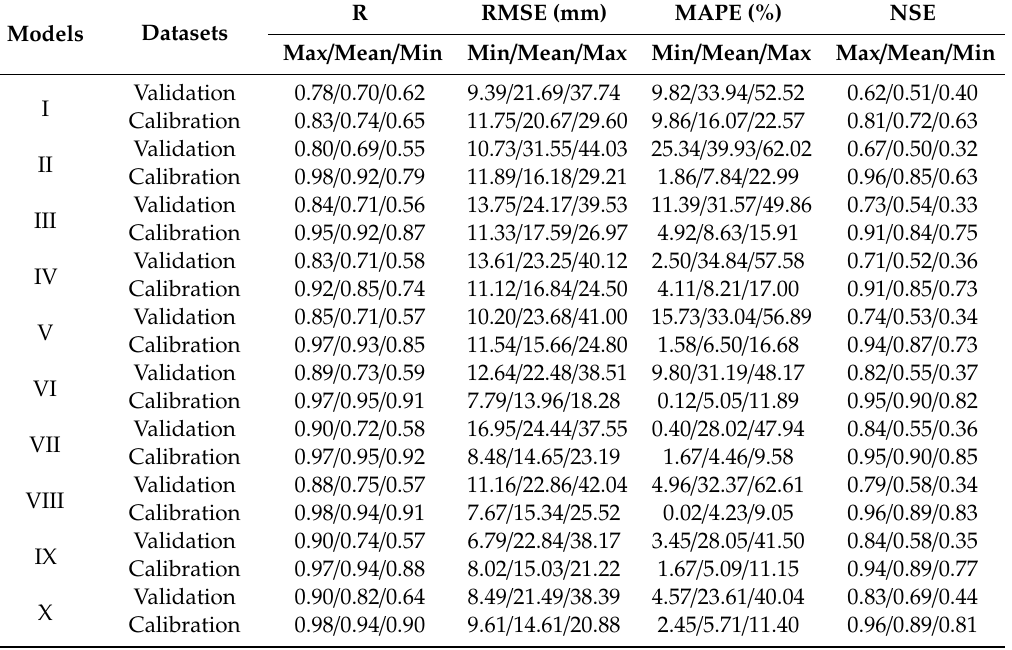
Table 4. Summary of correlation coe ffi cient (R), root mean square error (RMSE), mean